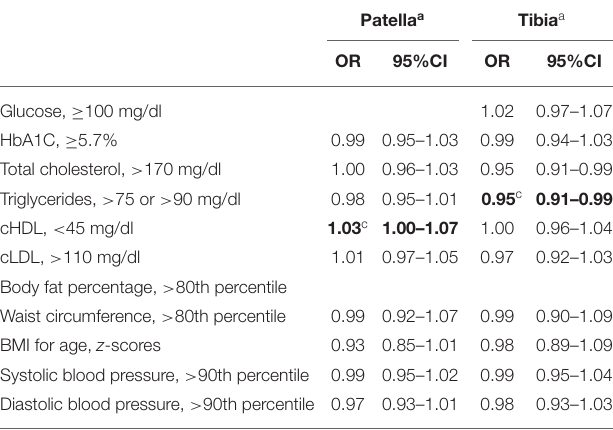
TABLE 5 | Associations between the lead levels in the trabecular (patella) and cortical (tibia) bone and indicators of metabolic syndrome categorized according to the cutoff